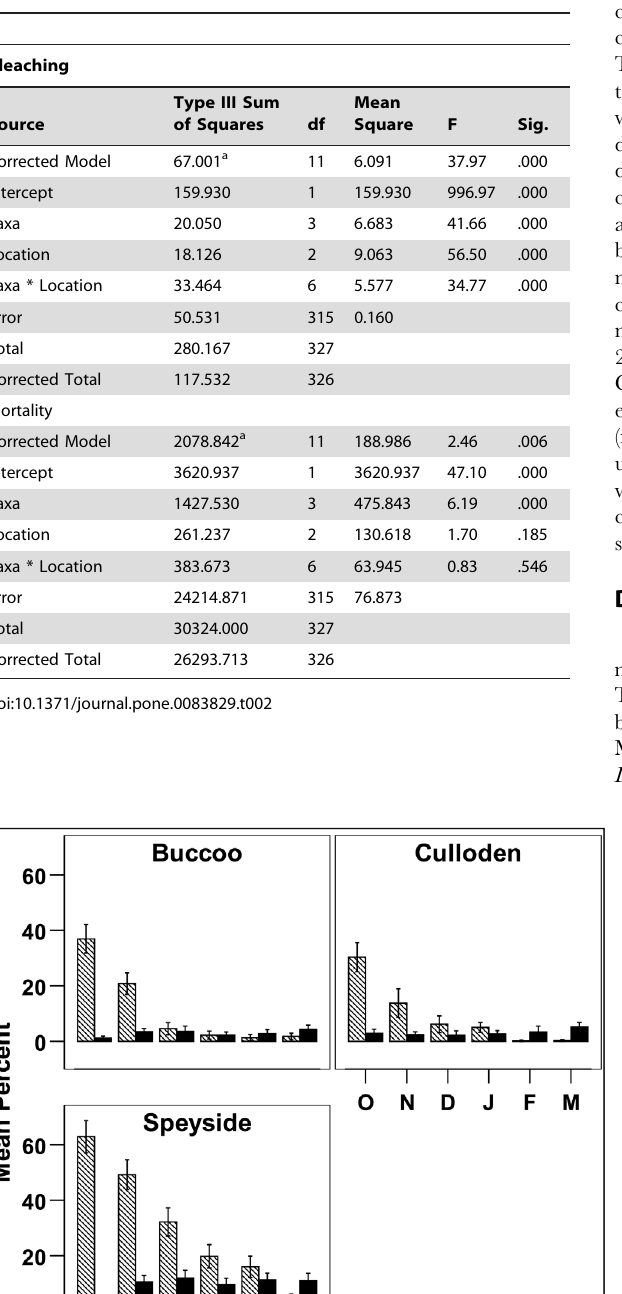
Table 2. Unbalanced GLM comparing the bleaching response (bleaching and bleaching mortality) at the onset of the 2010 mass bleaching event, between three reef and four reef building taxa in